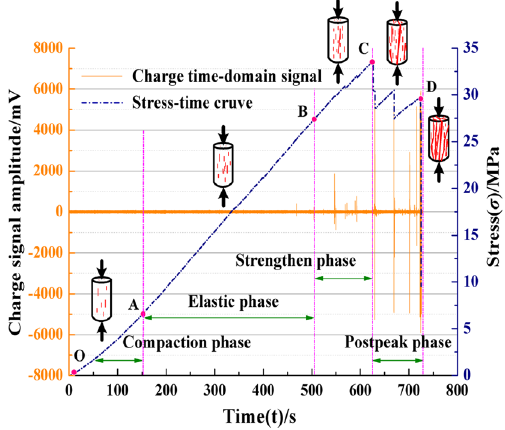
Fig. 10 A typical charge time-domain signal during coal under uniaxial